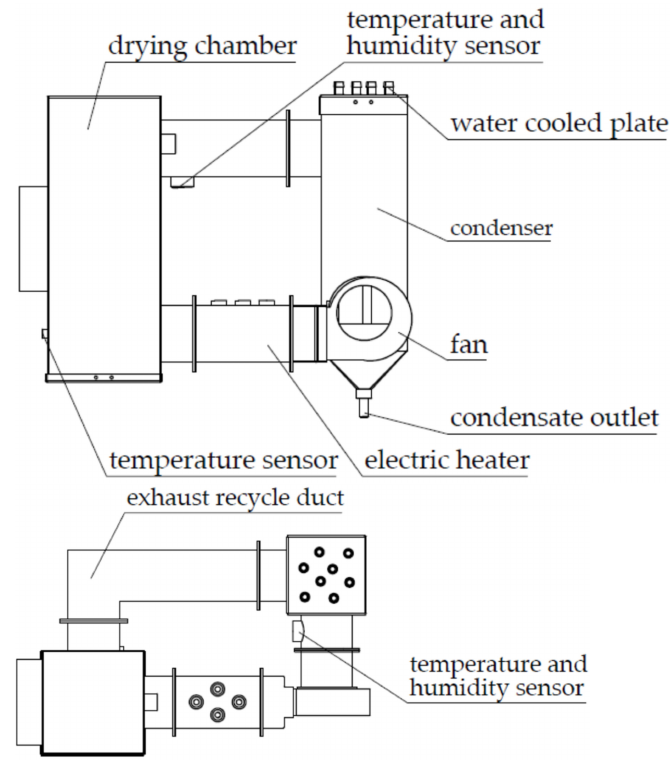
Figure 2. Design drawing of experimental